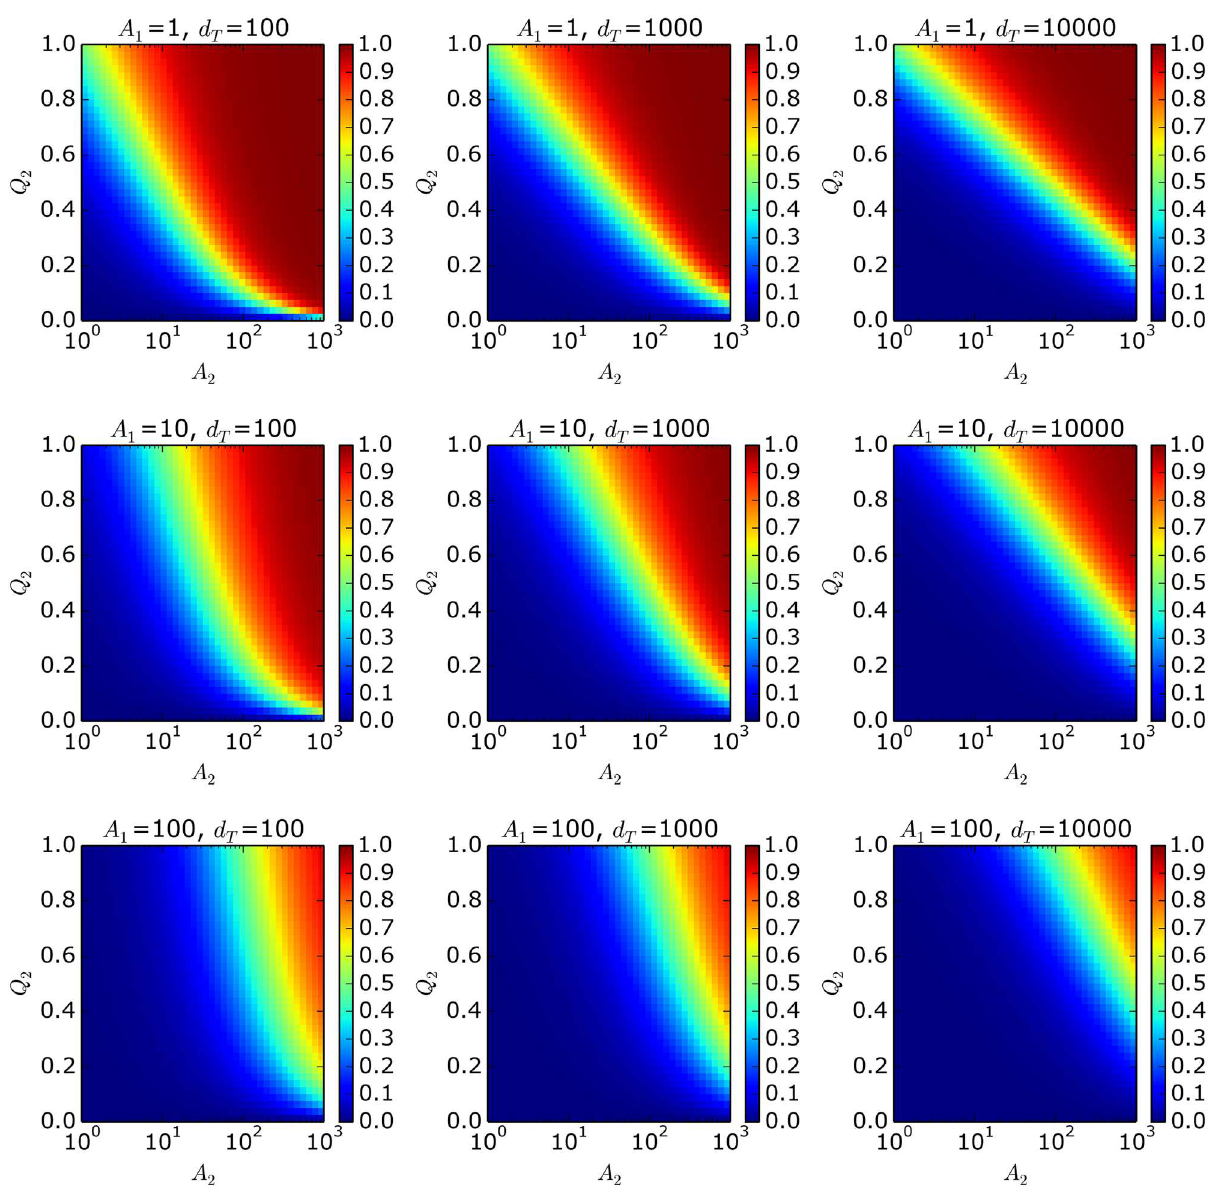
Fig 1. Market share of product 2 ( MS 2 ) as a function of Q 2 and A 2 , for different values of A 1 and d t